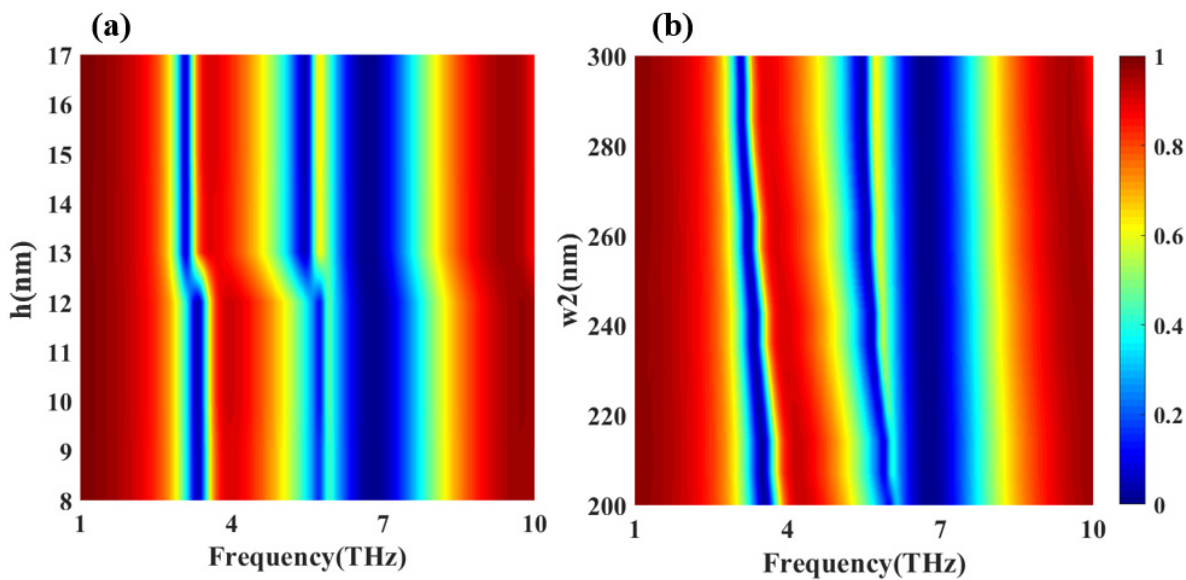
Figure 12. ( a ) The transmission efficiency as a function of the thin gold layer thickness for the frequency range of 1–10 THz. ( b ) The transmission efficiency as a function of the thin gold layer width for the frequency range of 1–10 THz.